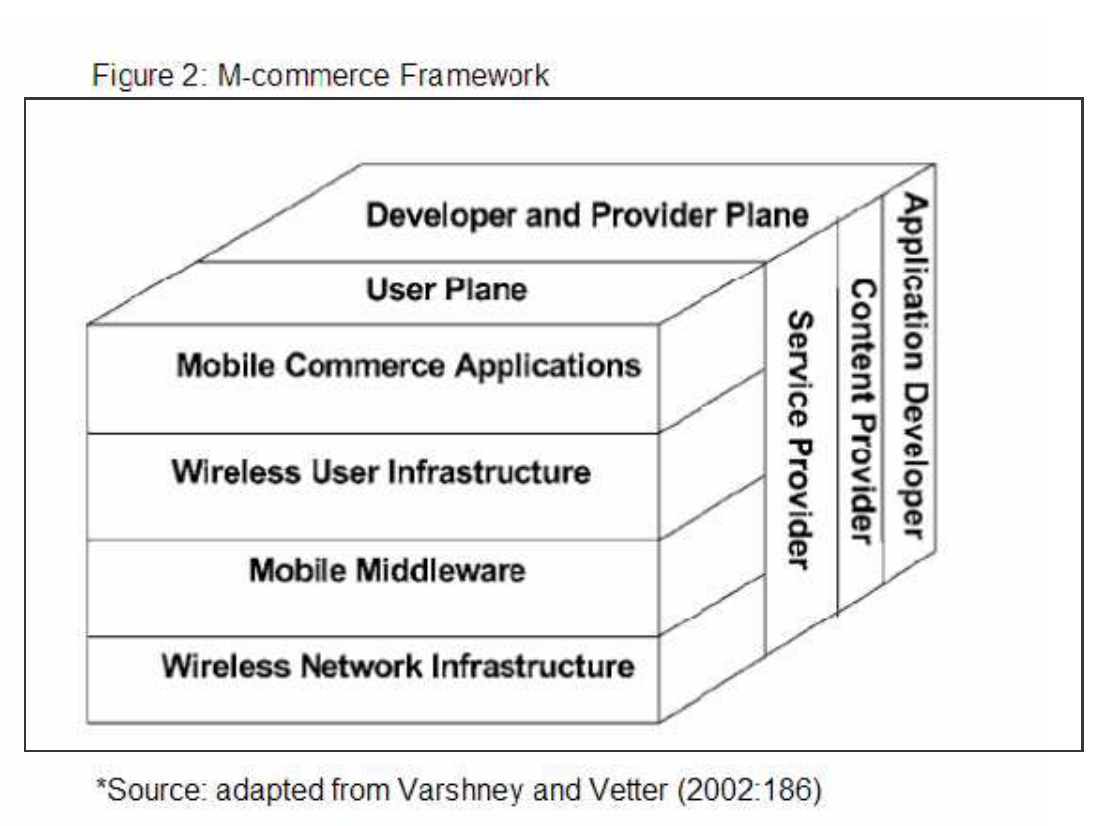
functioning and positioning of